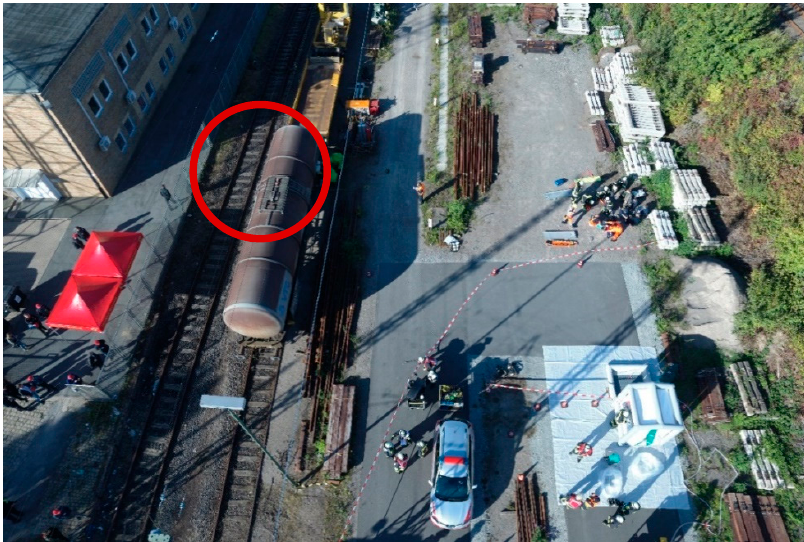
Figure 1. The place of the incident during the exercises in Dortmund during the e-Notice project. The place of the simulated leakage is marked with a red circle (21.09.2019 Radoslaw Fellner).